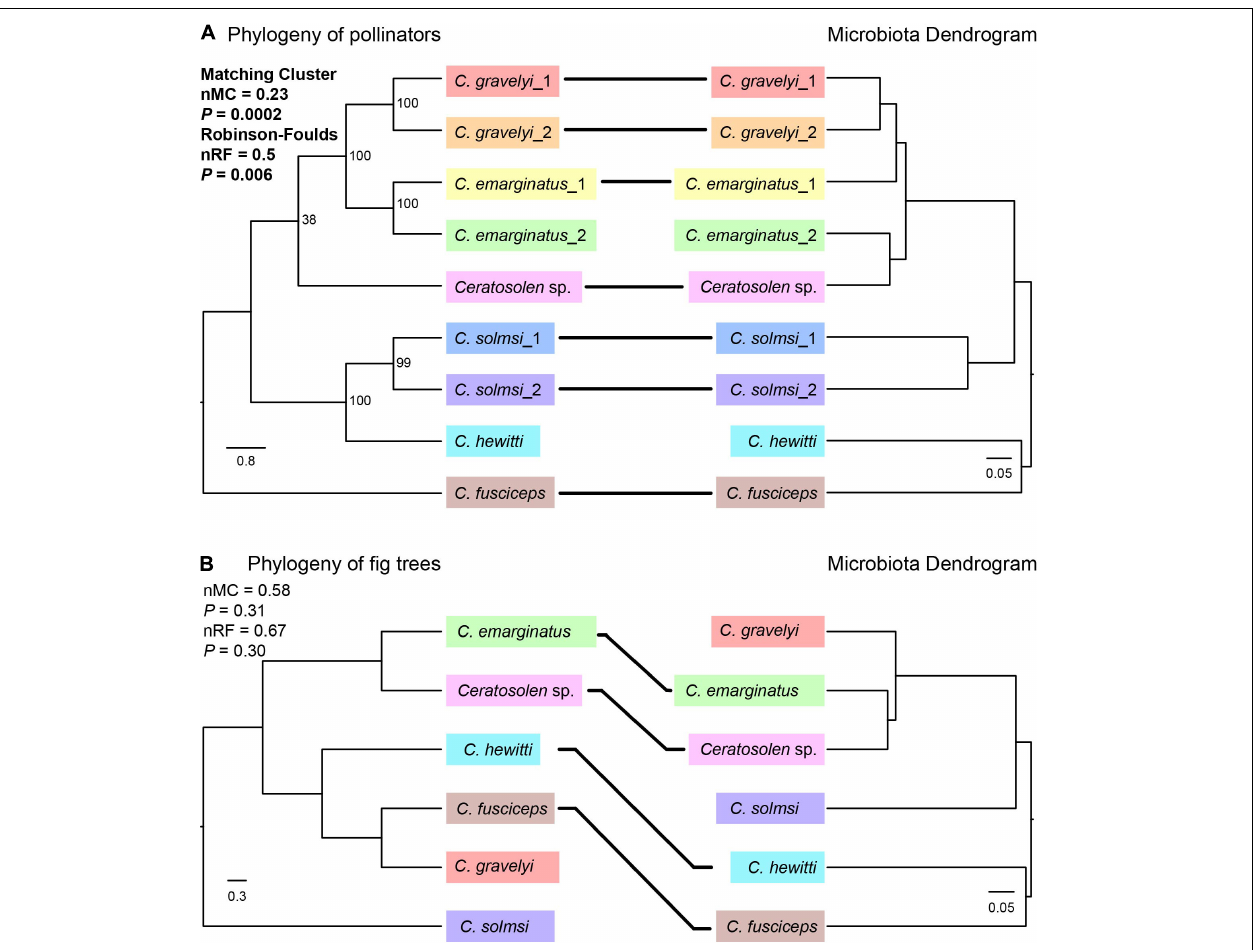
FIGURE 6 | Phylosymbiosis test between the phylogeny of pollinators (A) or fig trees (B) and microbiota dendrogram. The phylogeny of pollinators was based on CO1 and ITS2 sequences by ML method. The phylogeny of fig trees was based on ITS, ETS, and G3pdh genes by Bayesian method. For the convenience of comparison, the names of pollinators were used instead of the names of fig trees in the phylogenetic tree. Microbiota composition dendrogram was generated by the Bray–Curtis matrix. The nRF and nMC scores range from 0.0 (complete congruence) to 1.0 (complete incongruence). Solid lines connect species whose position is concordant between the phylogeny of pollinators or fig trees and microbiota